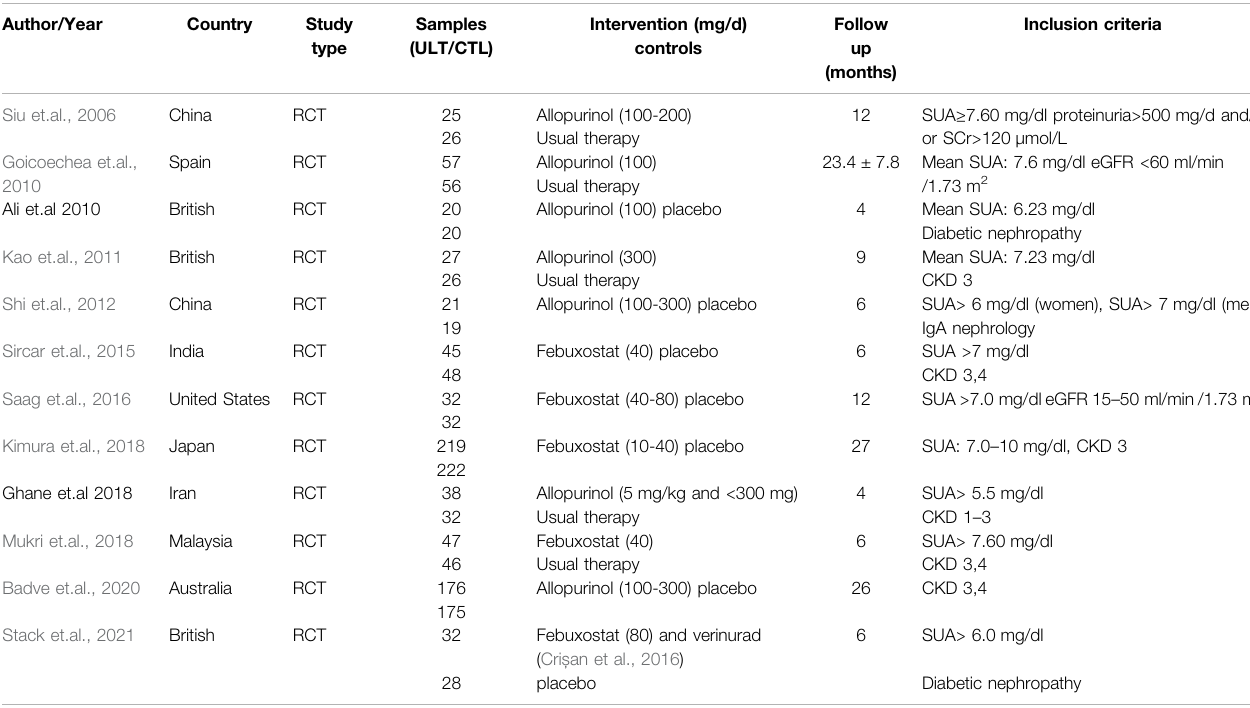
TABLE 1 | study characteristics of included